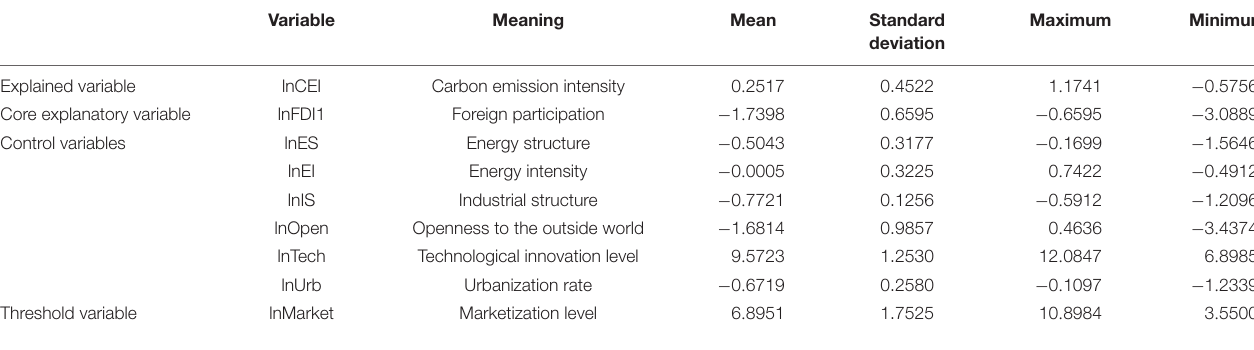
TABLE 1 | Descriptive statistics of